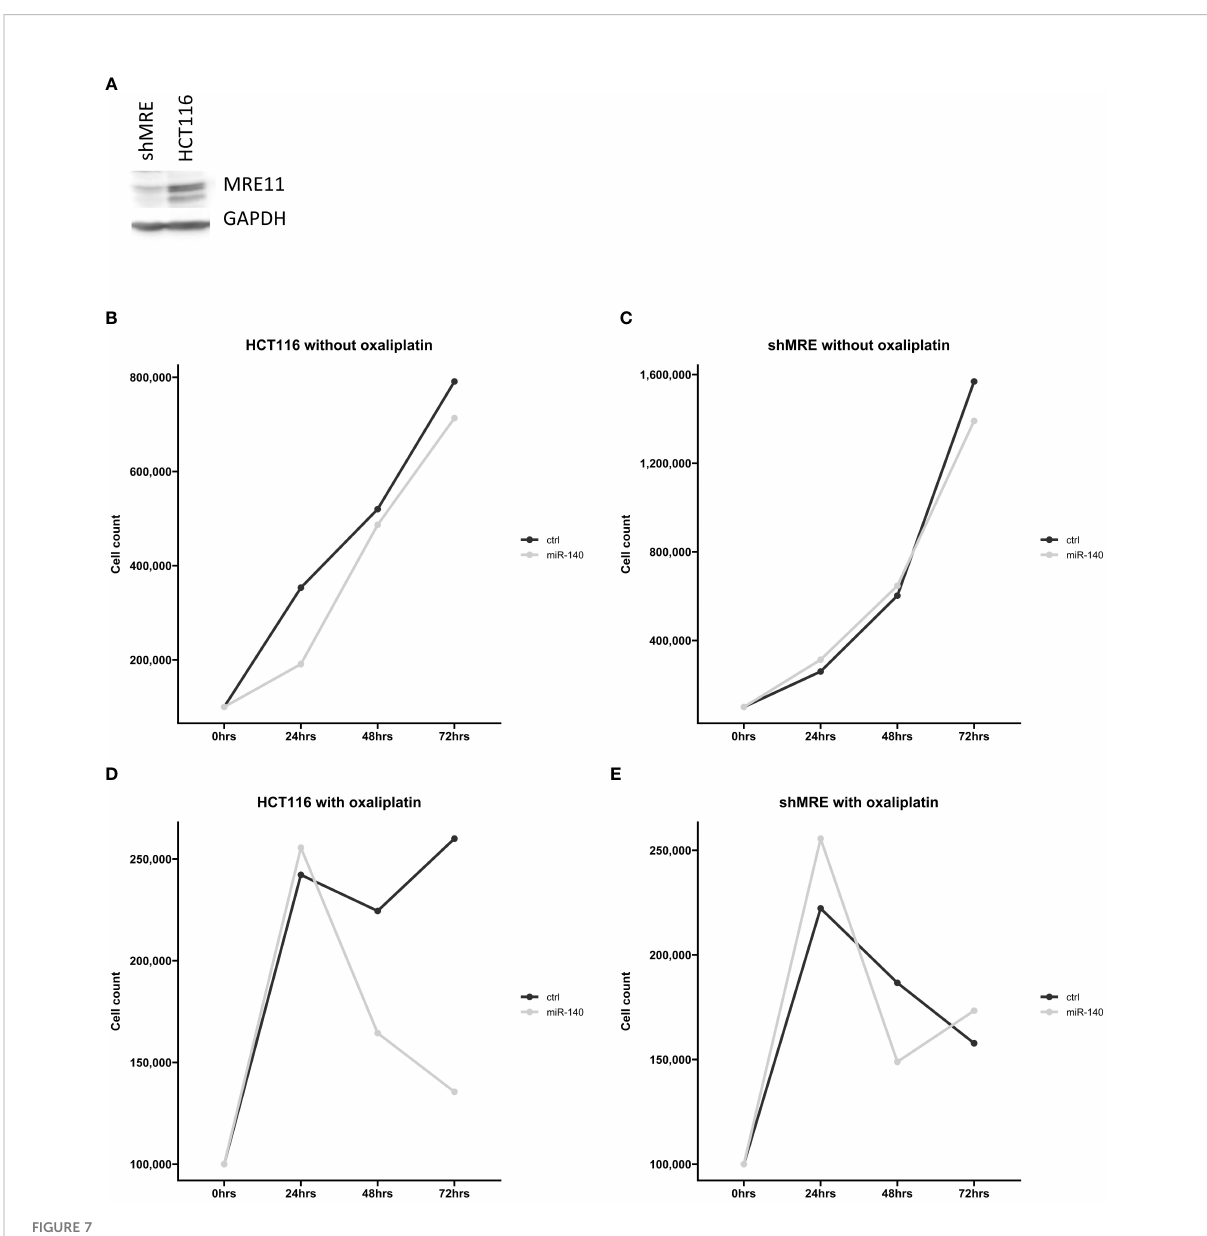
FIGURE 7 MiR-140 did not affect oxaliplatin sensitivity in shMRE11 cell lines. (A) Western blotting analysis of novel established cell line expressing recombinant lentiviruses MRE11 shRNA. (B) Cellular growth of parental cells HCT116 after overexpression of miR-140 was not changed. (C) Cellular growth of shMRE11 cells after overexpression of miR-140 was not changed. (D) Analysis of cellular growth of HCT116 with overexpression of miR-140 and oxaliplatin treatment showed decreased growth (p = 0.05). (E) Cellular growth of shMRE11 cells with miR-140 overexpression after oxaliplatin treatment was not changed. The results represent the mean value of three independent